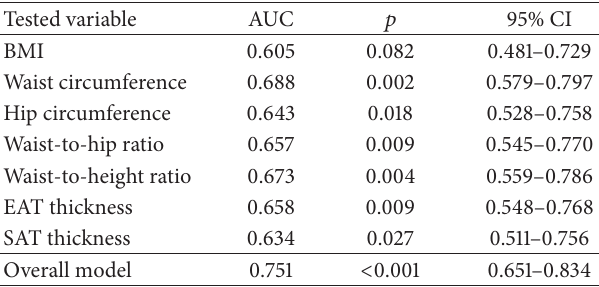
Table 2: Receiver Operating Characteristic (ROC) analysis for prediction of coronary artery disease (CAD) with anthropometric measures and ultrasonographically obtained epicaradial and subcu- taneous adipose tissue